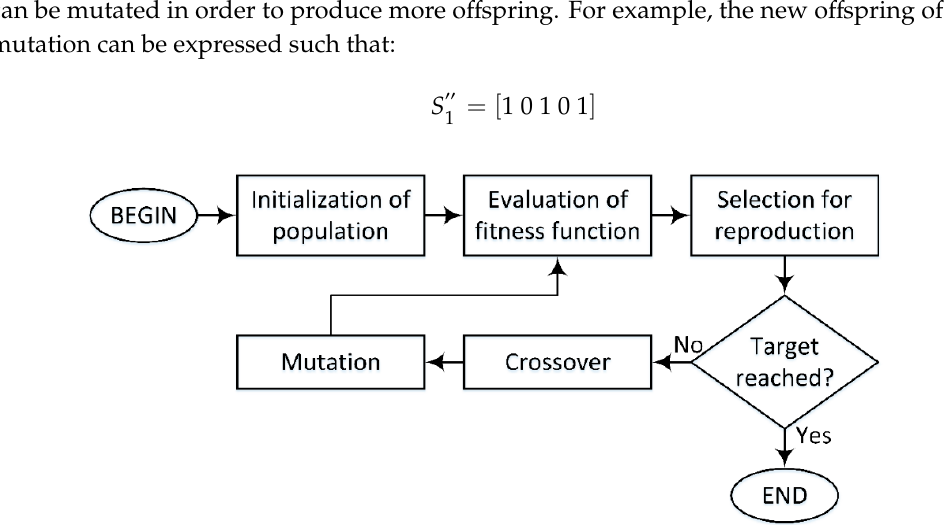
Figure 2. The structure of Genetic Algorithm.